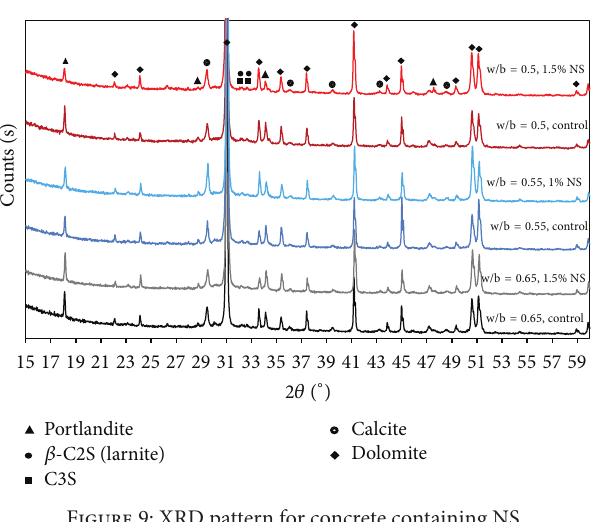
Figure 9: XRD pattern for concrete containing NS.